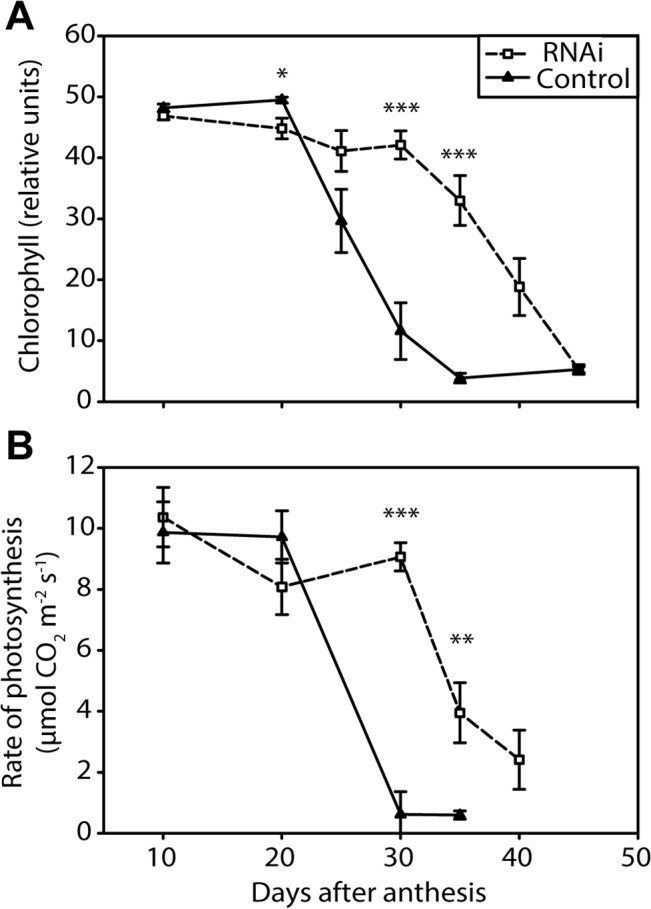
Flag leaf senescence characteristics of L19 NAM RNAi (open squares) and control (filled triangles) plants.(A) Chlorophyll. For each time point, each flag leaf was measured with a hand-held chlorophyll meter at ten positions across the surface. Values are means of the average measurements for flag leaves from six plants (biological replicates), ± SEM (standard error of the mean). (B) Photosynthesis. The rate of photosynthesis was measured under ambient conditions using a portable photosynthesis system. Values are means of measurements on four to six plants (biological replicates), ± SEM. Asterisks denote significant differences between genotypes at p < 0.05 (*), p < 0.01 (**) and p < 0.001 (***).